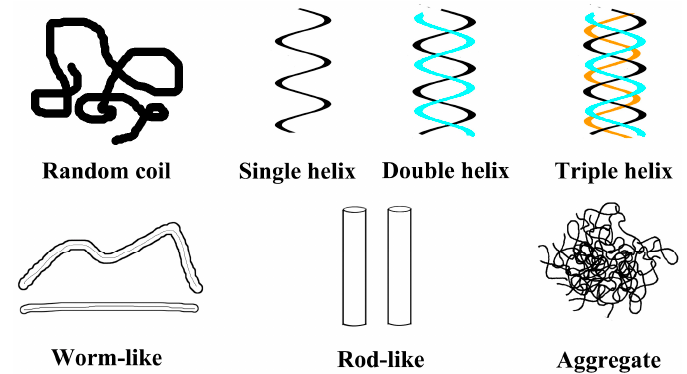
Figure 1. Scheme of possible polysaccharide chain conformations in aqueous solution.